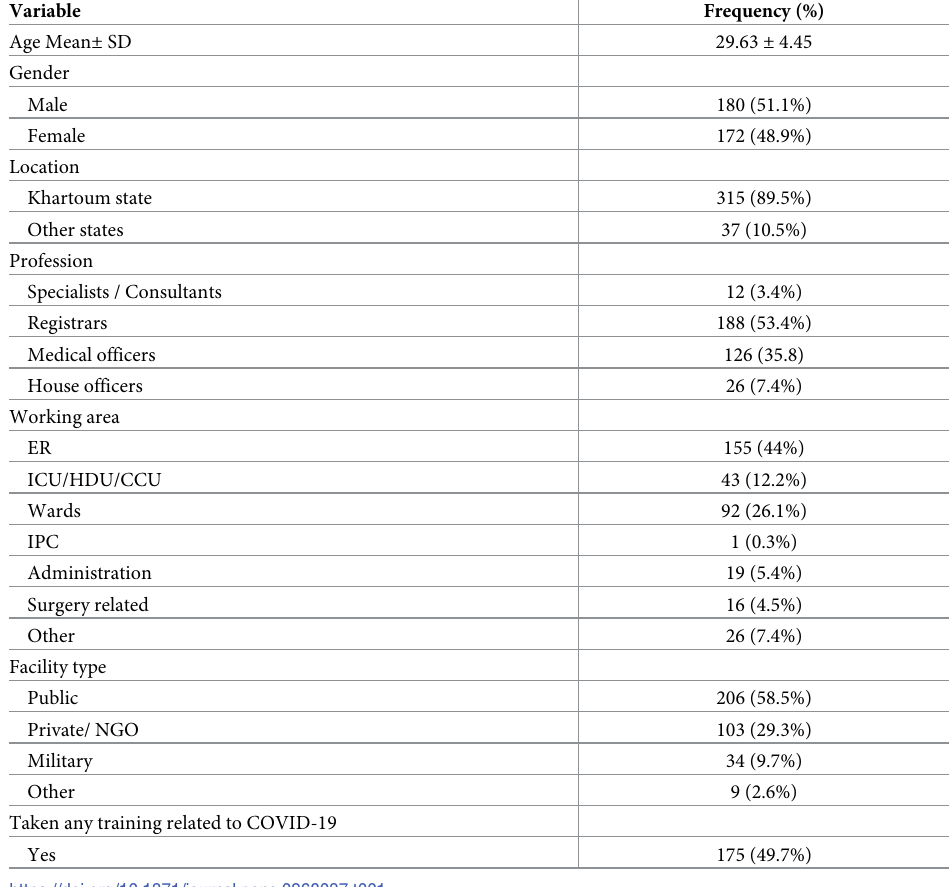
Table 1. Demographic characteristics of the participants (n =